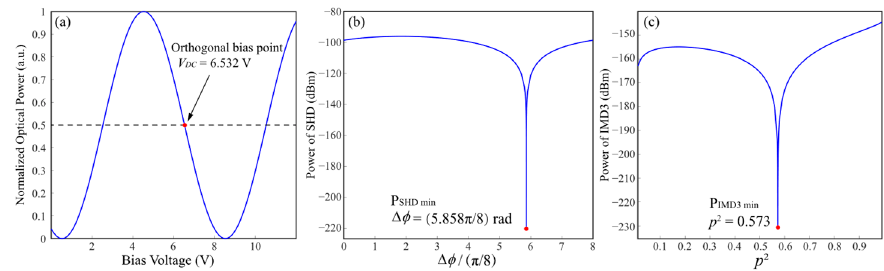
Figure 10. The process of finding the linear operating point: ( a ) V DC , ( b ) Δ ϕ , and ( c ) p 2 .